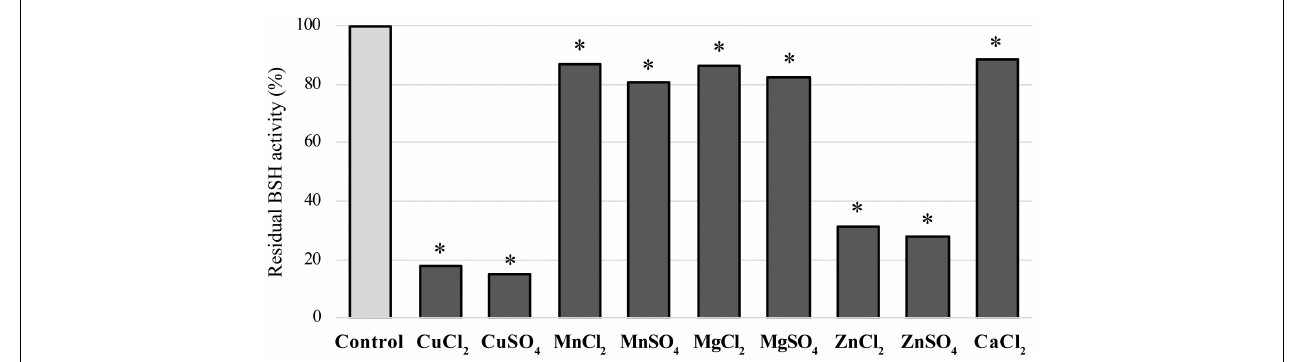
FIGURE 3 | Effects of ion compounds on LapBSH activity. LapBSH proteins were pre-incubated with each of the nine metal ions at a final concentration of 5 mM for 30 min at 37 ◦ C. BSH activities were measured based on the activity of the pre-incubated LapBSH enzymes toward TDCA. Values represent the mean of eight technical replicates ( n = 8). Maximum activity was recorded as 100%. Error bars indicate SD. ∗ A p -value less than 0.05 ( P < 0.05) was defined as statistically